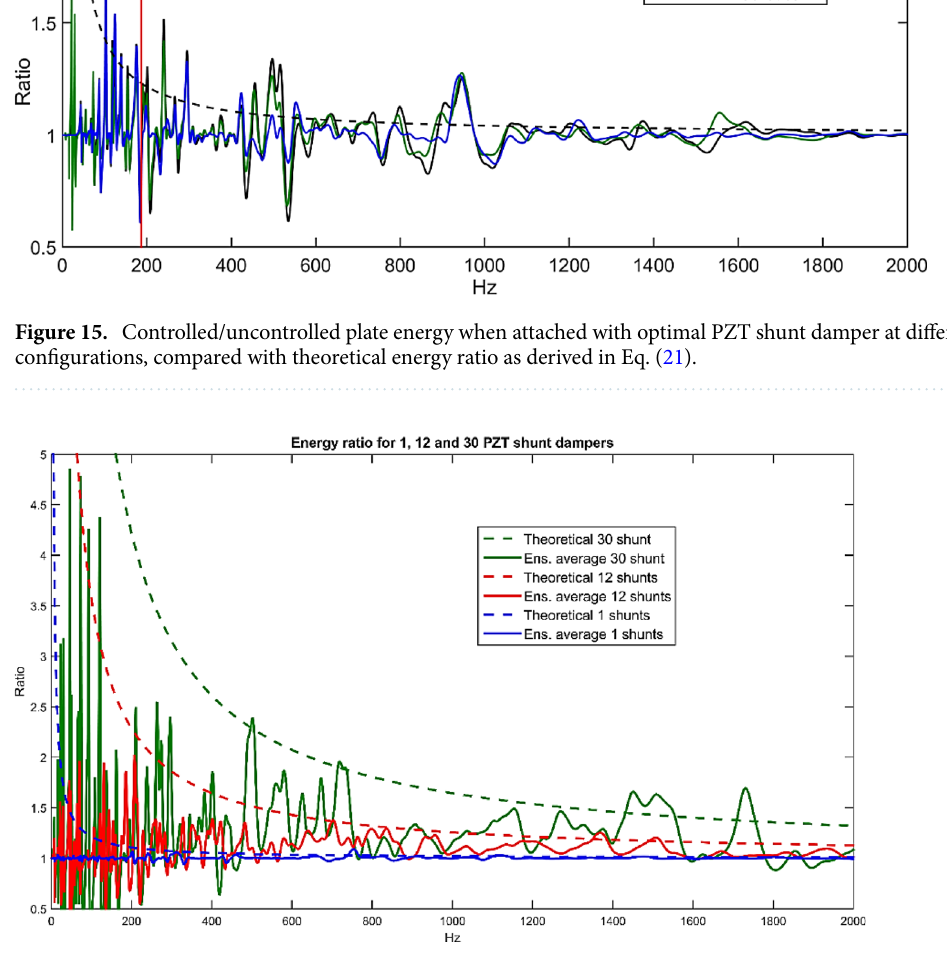
Figure 16. Controlled/uncontrolled plate energy when attached with various quantity of optimal PZT shunt dampers, compared with theoretical energy ratio as derived in Eq.